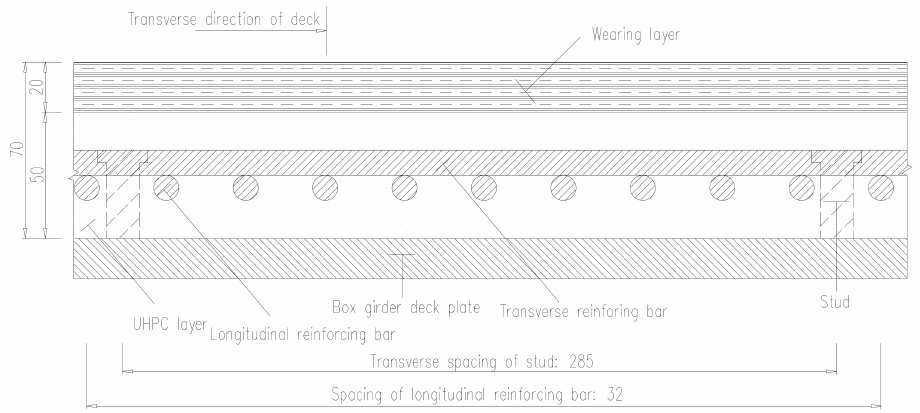
Figure 2. Cross section of composite deck with ultra high performance concrete (UHPC) (unit: mm).